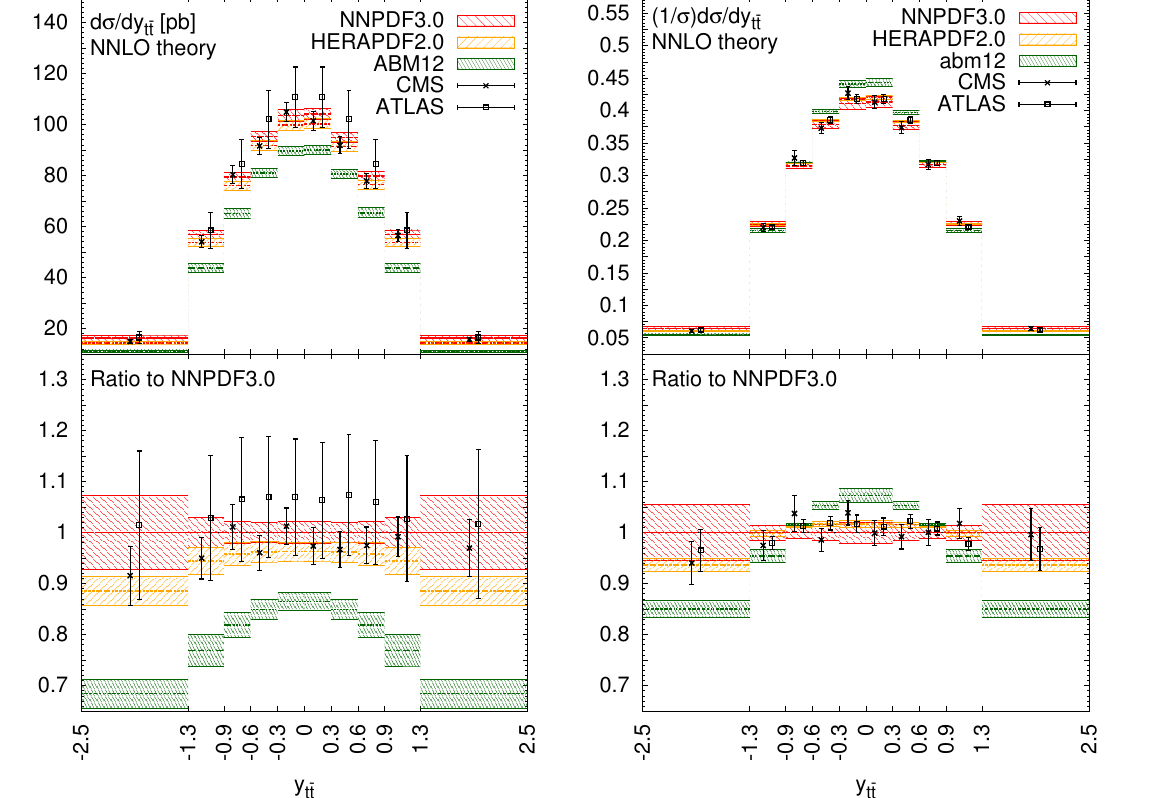
Figure 10 . Same as (cid:12)gure 9 now for NNPDF3.0, ABM12 and